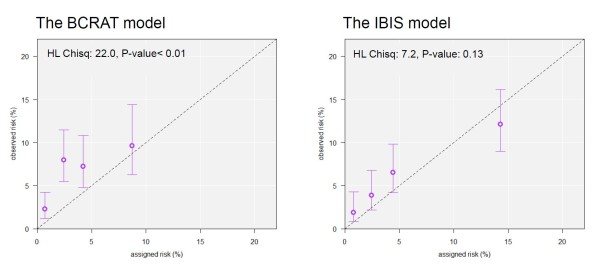
Calibration of BCRAT and IBIS models. The horzontal coordinates of points represent the mean 10-year assigned risks of BCRAT (left panel) and IBIS (right panel) within quartiles of assigned risk. Vertical coordinates represent quartile-specific estimates of 10-year breast cancer probabilities (observed risks). Vertical bars represent 95% confidence intervals for observed risks.